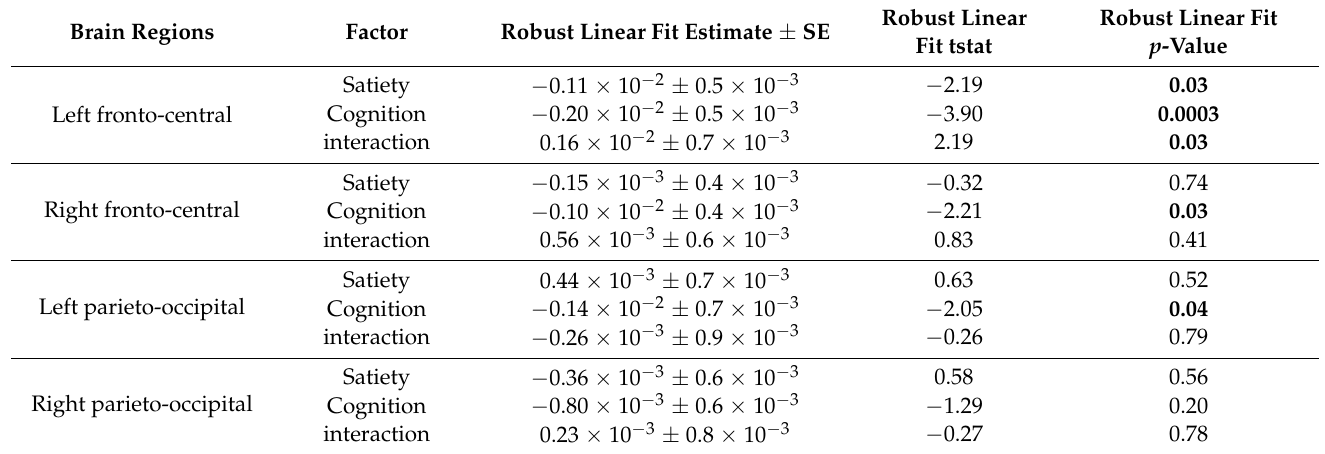
Table 1. Robust linear regression effects of satiety and cognitive state on PAC. The table summarizes the regression weights, tstat and the p -value, for the coefficients denoted by the factor column for each of the electrode models. Significant p -values less than 0.05 are in